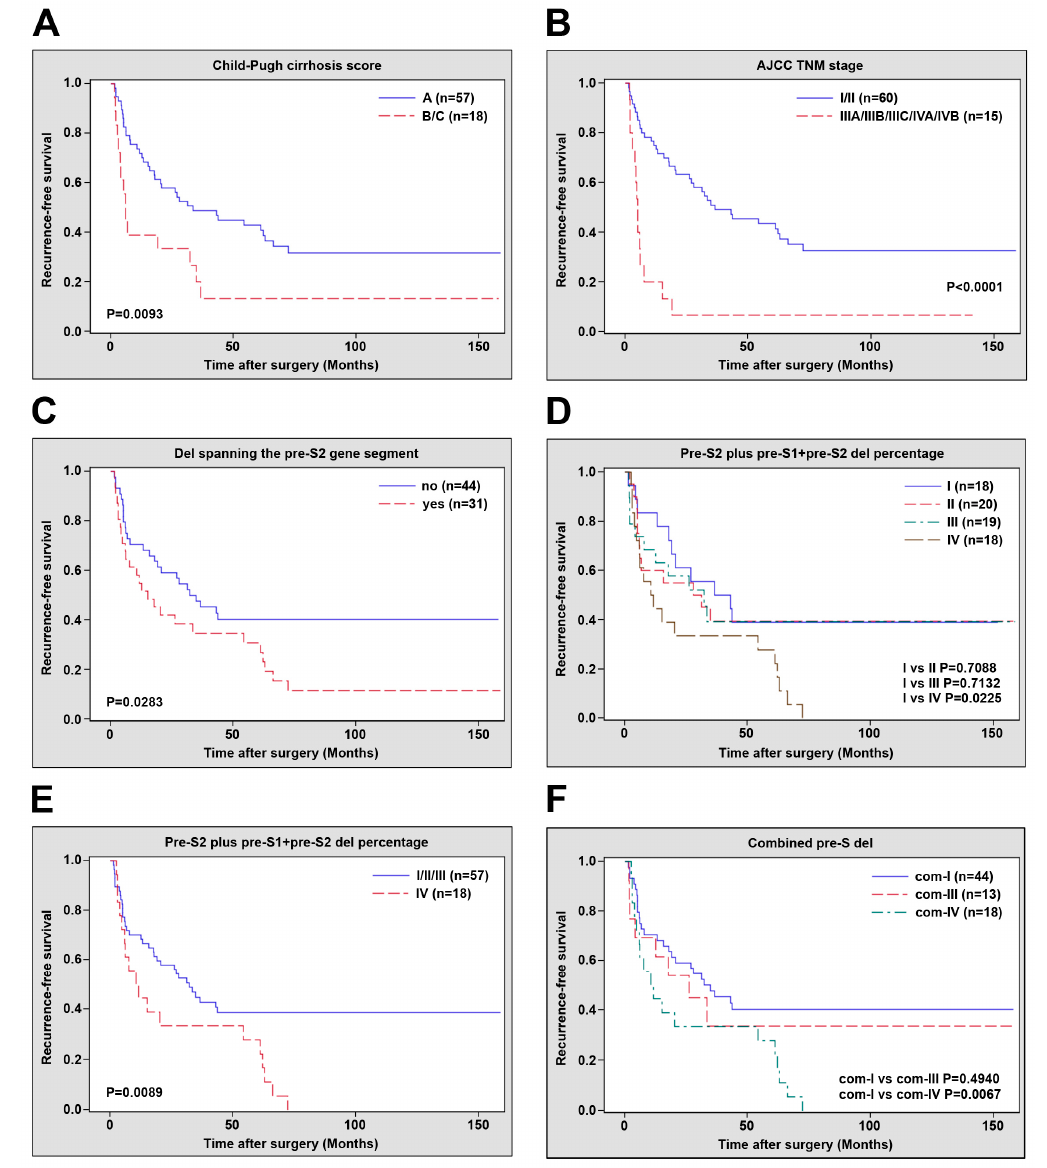
Figure 2. Kaplan–Meier curves of RFS differences in the 75 HBV-related HCC patients after surgical resection. ( A ) RFS in patients with Child–Pugh cirrhosis score A versus B/C. ( B ) RFS in patients with AJCC TNM stage I/II versus IIIA/IIIB/IIIC/IVA/IVB. ( C ) RFS in patients with (yes) versus without (no) deletions spanning the pre-S2 gene segment. ( D ) RFS in patients with pre-S2 plus pre-S1 + pre-S2 deletions percentage I versus II, III, or IV, respectively. ( E ) RFS in patients with pre-S2 plus pre-S1 + pre-S2 deletions percentage I/II/III versus IV. ( F ) RFS in patients with combined pre-S deletions com-I versus com-III or com-IV, respectively. RFS rate was plotted against months after surgery. P values numbers (n) of patients were indicated in the plots. A p value < 0.05 was considered